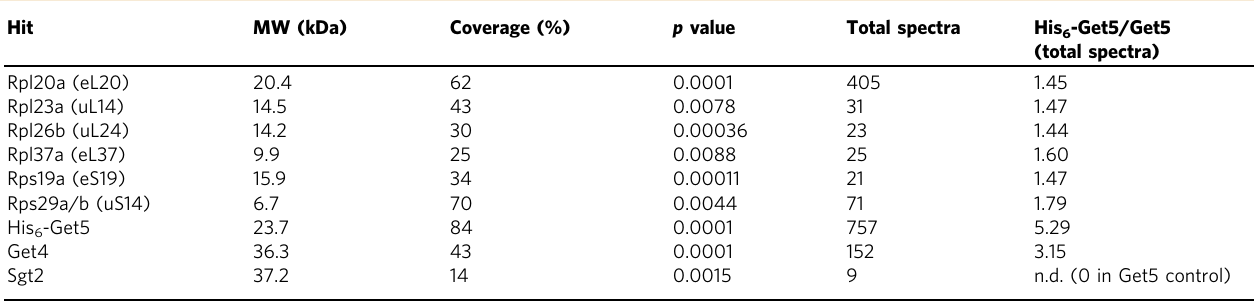
Table 1 Contacts of Get5 to ribosomal proteins identi fi ed by mass spectrometry.